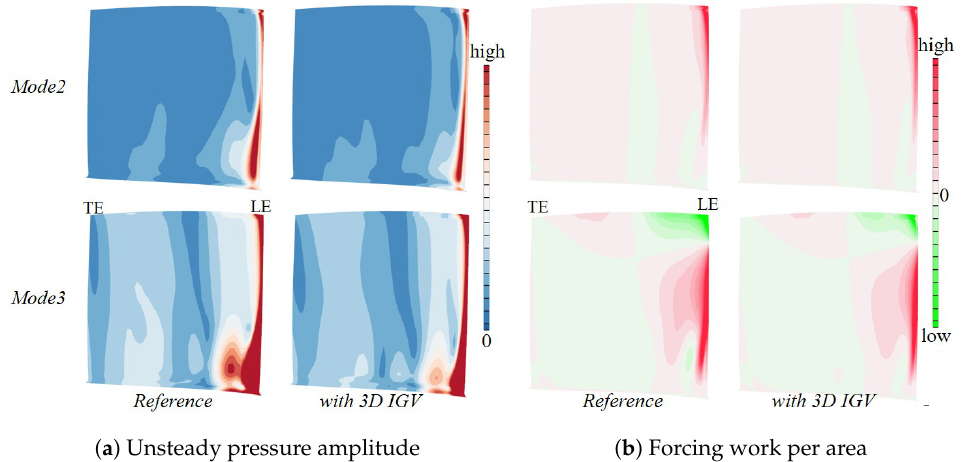
Figure 17. Distribution of pressure and work on the suction side. Comparison between the reference and the 3D blading of